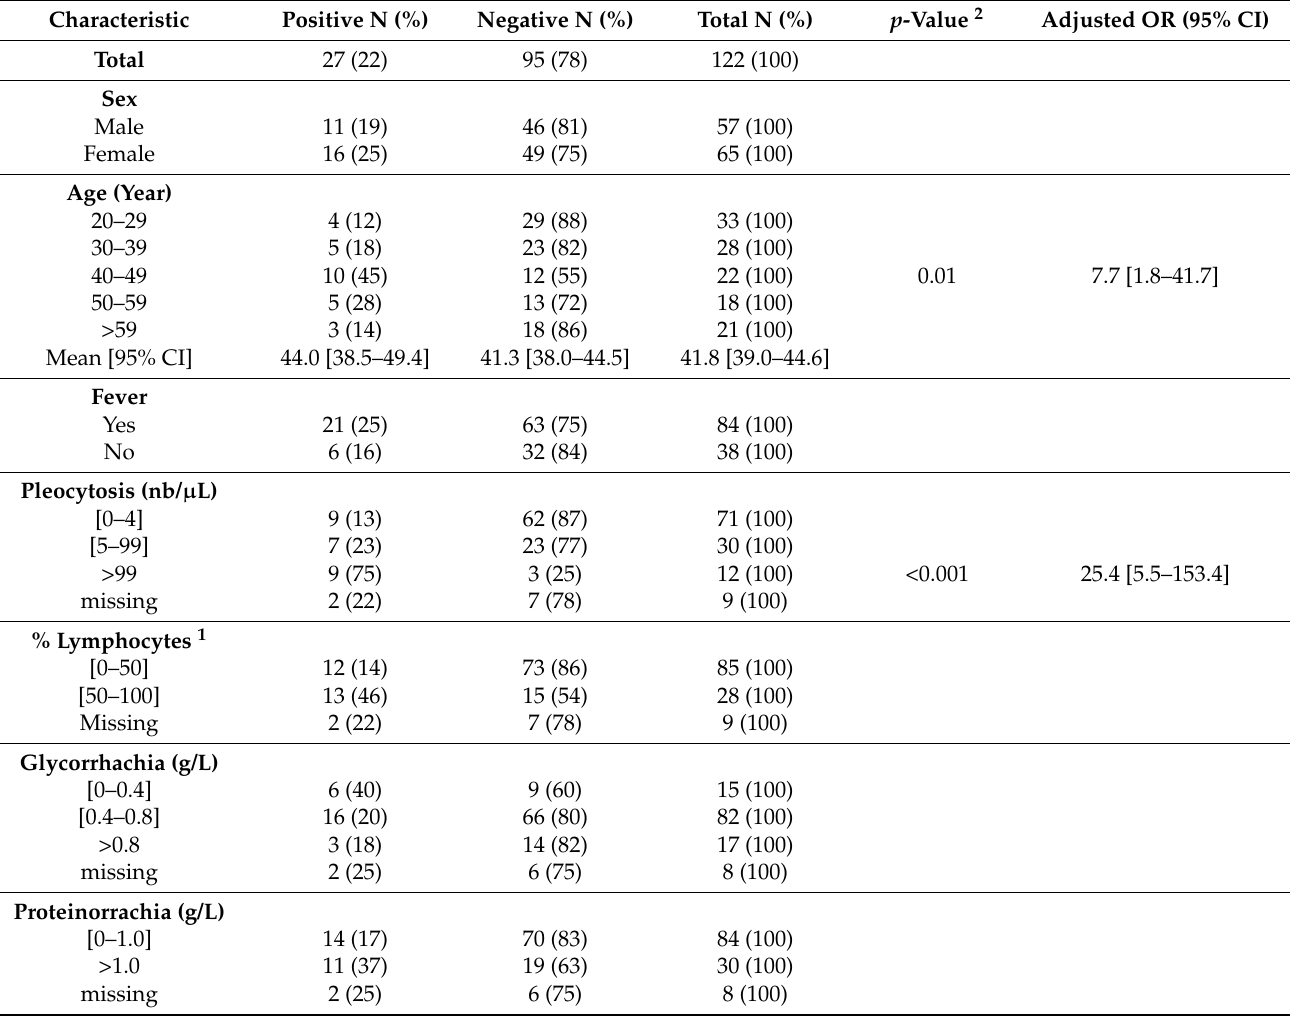
Table 2. Characteristic of encephalitic patients according to viral detection, Dakar, January– December